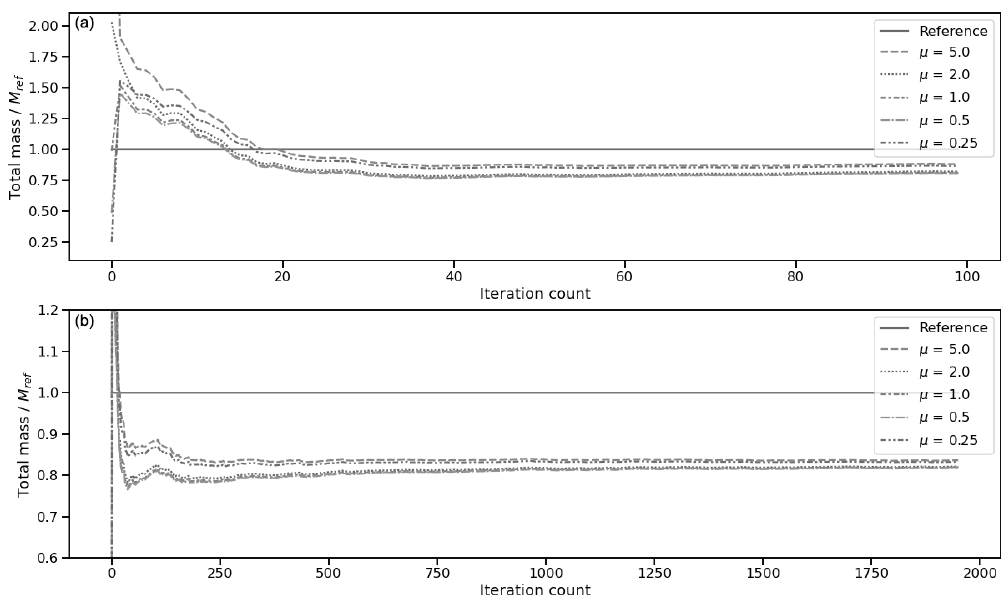
Figure 4. Evolution of total mass over time for five different forecast simulations with five different initial total masses (Table 1) over 100 assimilation iterations (a) and 2000 iterations (b) . The total mass evolution of the reference simulation is indicated by a solid line.